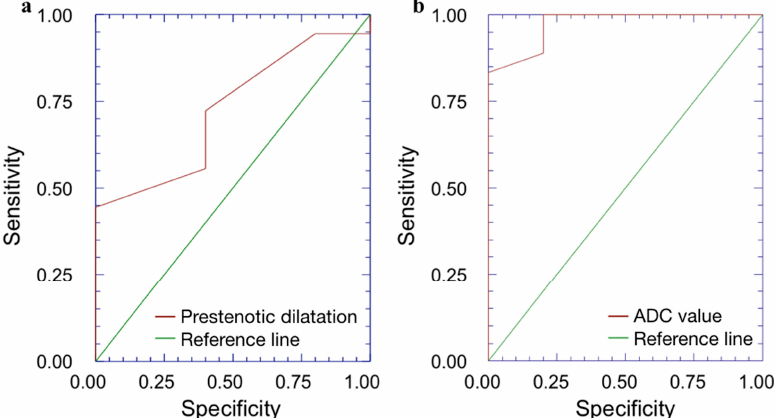
Figure 5. ( a , b ). Receiver operating characteristic (ROC) analysis. ( a ) The ROC curve shows that pre-stenotic upstream bowel dilatation has a high accuracy with AUC 0.75 ( p < 0.001) for discriminating between none and mild/moderate– severe bowel wall fibrosis. ( b ) The ROC curve demonstrates that ADC shows a high accuracy with AUC 0.97 ( p < 0.001) for discriminating between none and mild/moderate–severe bowel wall fibrosis. ADC = apparent diffusion coefficient, AUC = area under ROC curve.